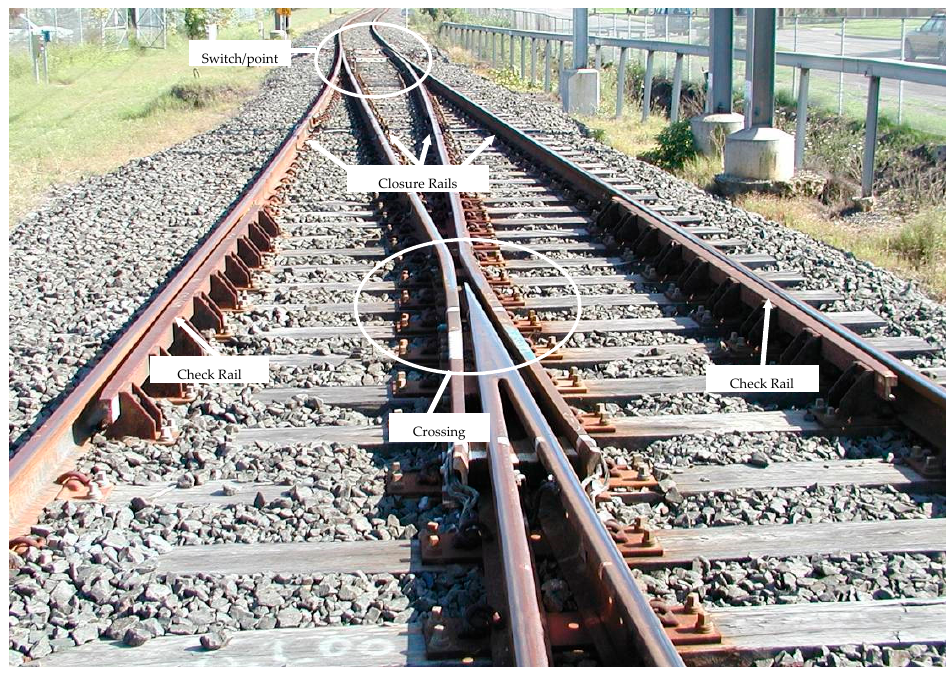
Figure 1. Typical turnout geometry.